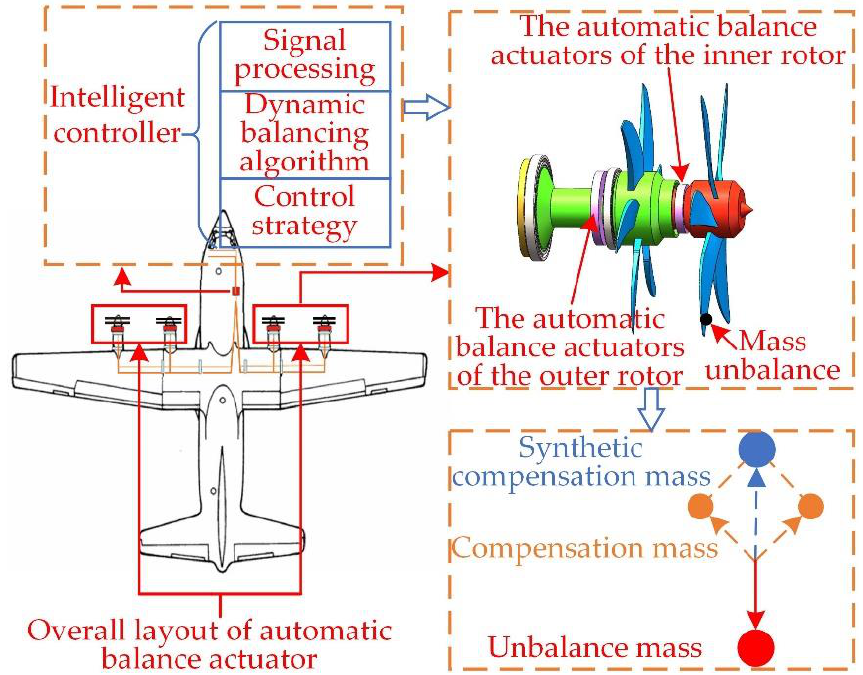
Figure 2. The cantilevered coaxial dual-rotor automatic balance system.